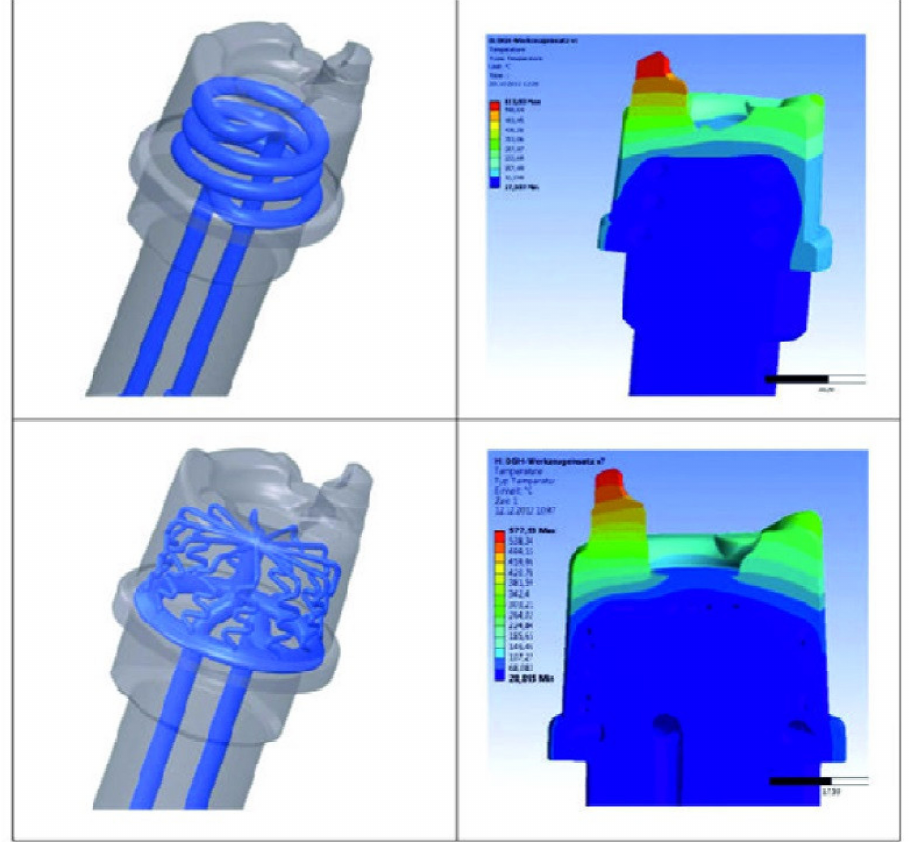
Figure 23. The insert in Figure 22: Stepwise optimization of the cooling channels, ranging from spiral design to a complex system of small channels [133].